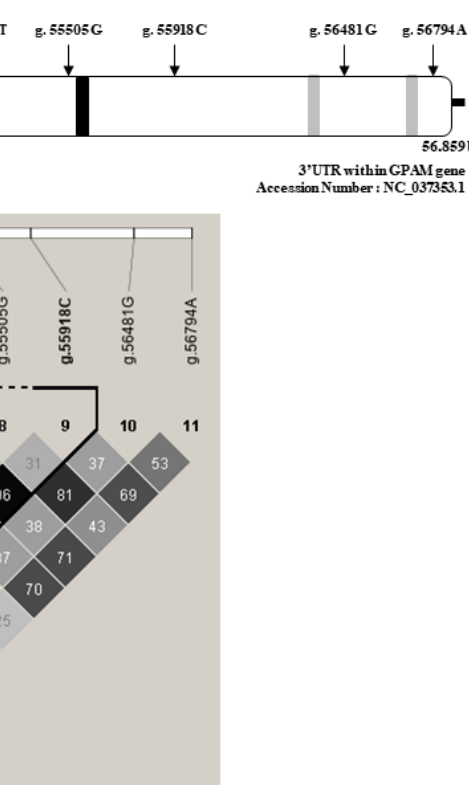
Arch. Anim. Breed., 64, 27–33,